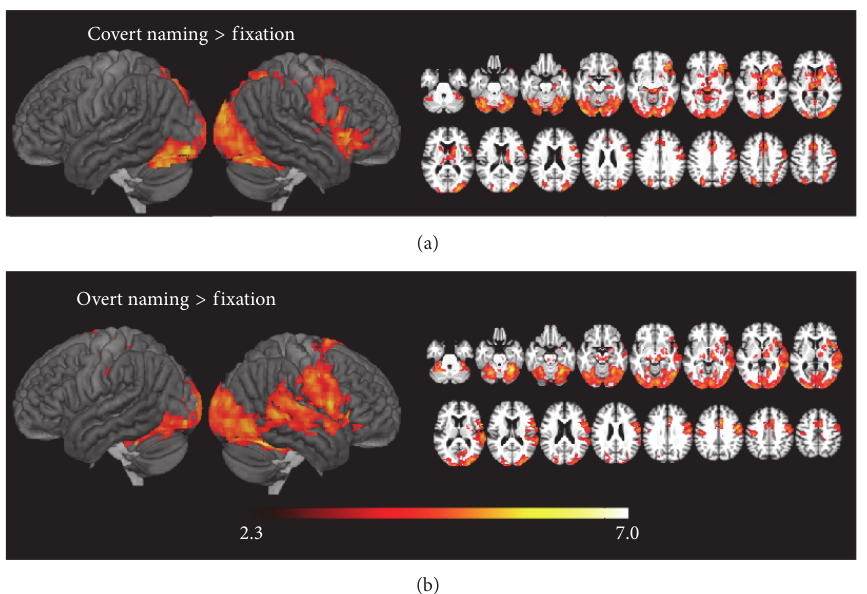
Figure 2: Regions where large left hemisphere lesions were related to greater activity during (a) covert naming and (b) overt